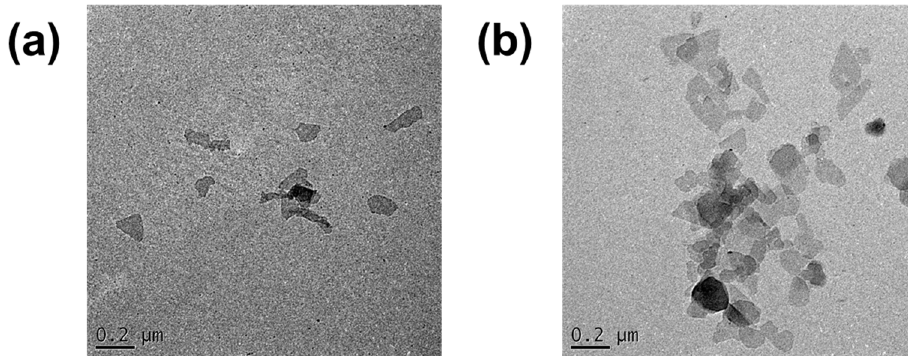
Figure 3. Particle morphology of ( a ) Na-MMT and ( b ) O-MMT.